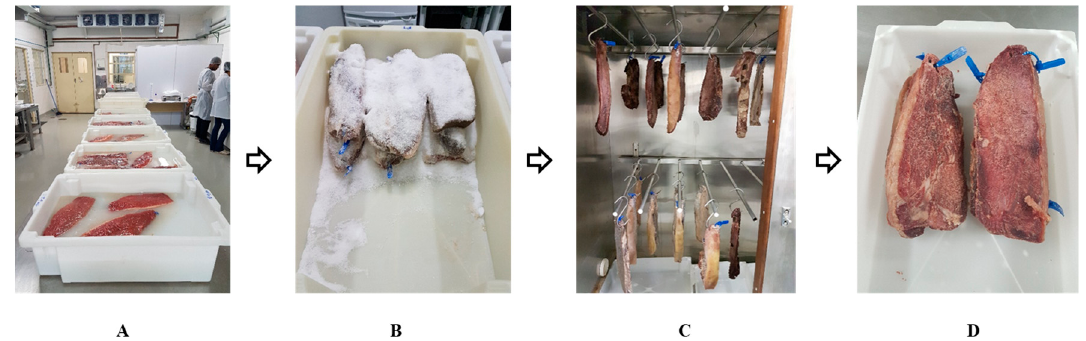
Figure 1. Processing steps for obtaining salted meat. A : wet salting; B : dry salting; C : maturation; D : final product.